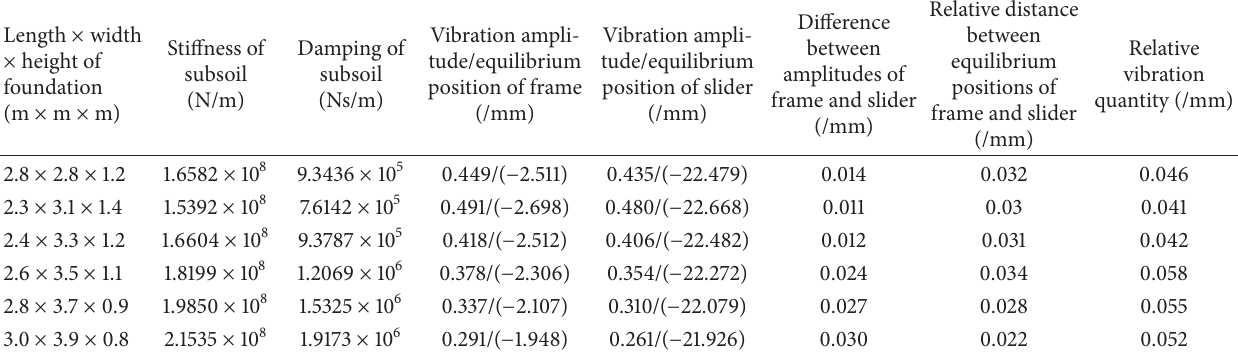
Table 7: Vibration quantity of the punching press for a series of foundations with the same mass of 22,767 kg. Length × width × height of